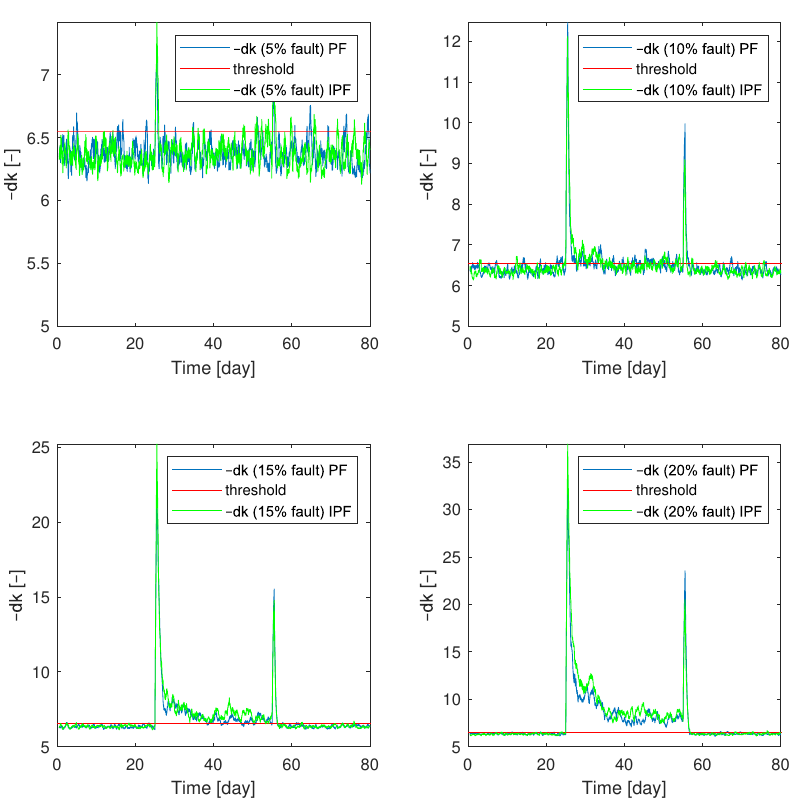
Figure 11. Operation with a fault: results according to different fault amplitudes belonging to general PF and IPF. One of the setpoint changes occurs within the fault duration and one once it has been resolved, as is seen in Figure 10. The threshold is h = 6.57, calculated by the 98% confidence interval of the fault-free operation. Sliding window is M = 50. T =